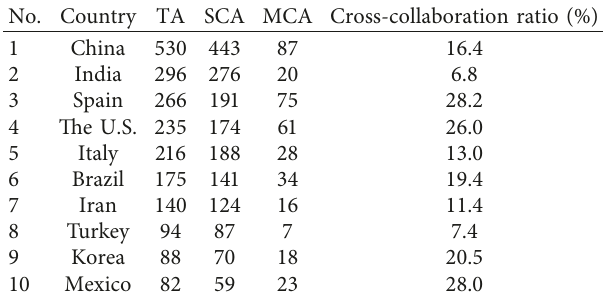
Table 3: The collaboration level of the top ten scientific production countries.